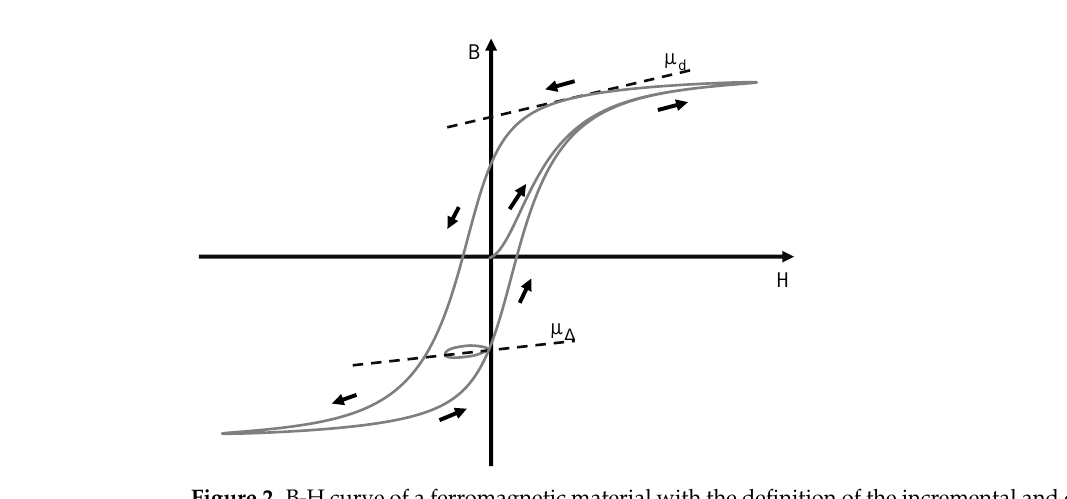
Figure 2. B-H curve of a ferromagnetic material with the definition of the incremental and differential permeability, adopted from [33].